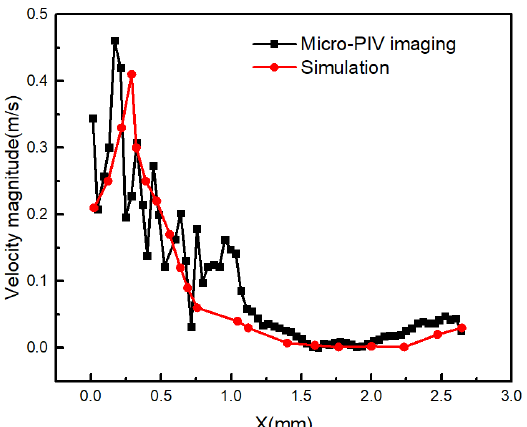
Figure 4. The curve of velocity versus position from the tip to the rear of the liquid column.